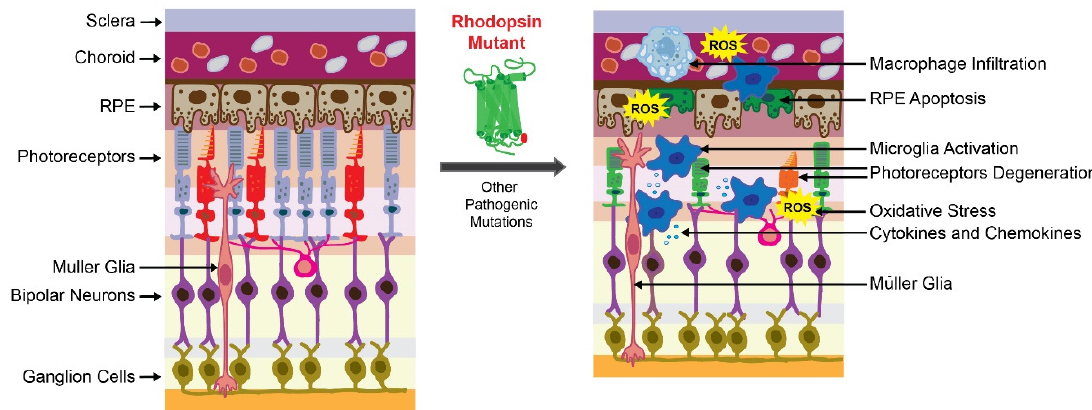
Figure 1. Retinal degeneration in retinitis pigmentosa (RP). The scheme of the healthy retina is shown on the left. The scheme of the degenerated retina caused by the RP-related mutation is shown on the right. The presence of the mutant receptor triggers degeneration of photoreceptors and retinal pigment epithelium (RPE) cells that are critical for retinal homeostasis. In RP, a genetic insult that causes protein misfolding is associated with the activation of cellular unfolded protein response (UPR) and overproduction of reactive oxygen species (ROS), leading to oxidative stress in the retina. Altogether, these factors activate the inflammatory response orchestrated by microglia and macrophages to clear dying photoreceptors. These immune cells release inflammatory mediators that become dysregulated under persistent insult related to the mutant receptor and increase retinal damage. In addition, mutations in other genes related to phototrans- duction, retinoid cycle, and maintenance of photoreceptors can cause RP.